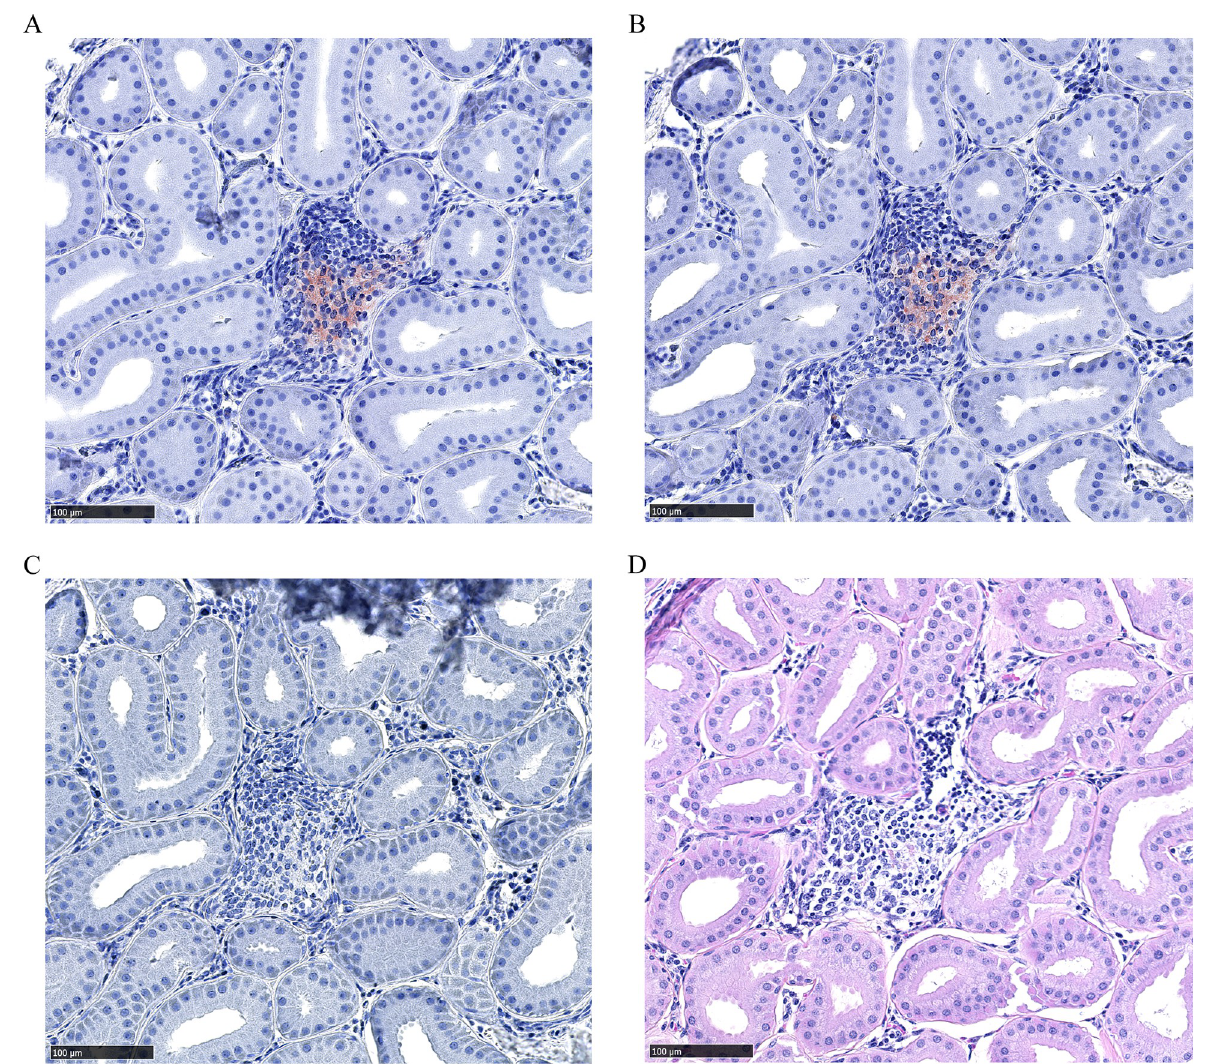
Fig 2. PrP CWD immunolabeling between sudoriferous glands of a female mule deer hind interdigital gland. (A-B) Adjacent sections of immune cell infiltrates between sudoriferous glands with PrP CWD immunolabeling (red). PrP CWD was immunolabeled with anti-PrP BAR224 (1:2,000). (C) Negative control section without primary antibody. (D) Hematoxylin and eosin